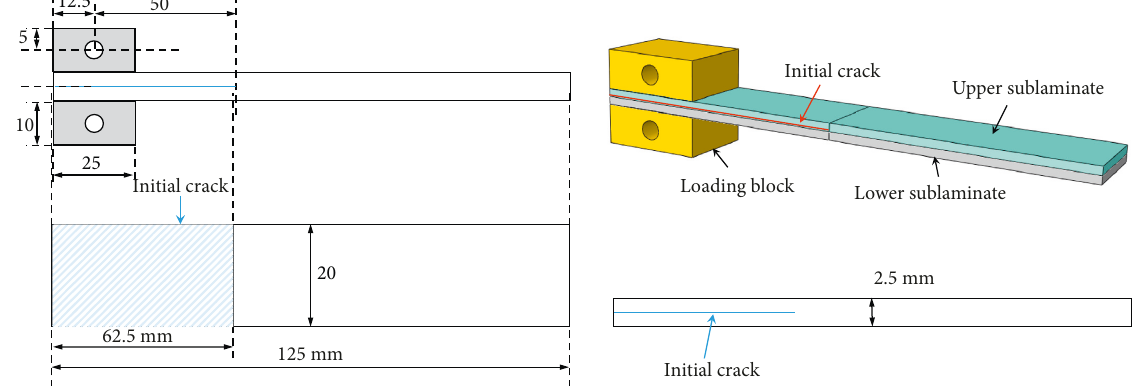
Figure 12: DCB: specimen